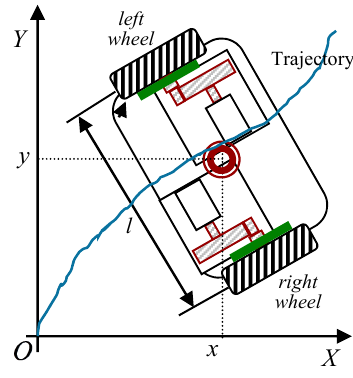
Figure 1. Reference frame of a two-wheeled mobile robot (revised from